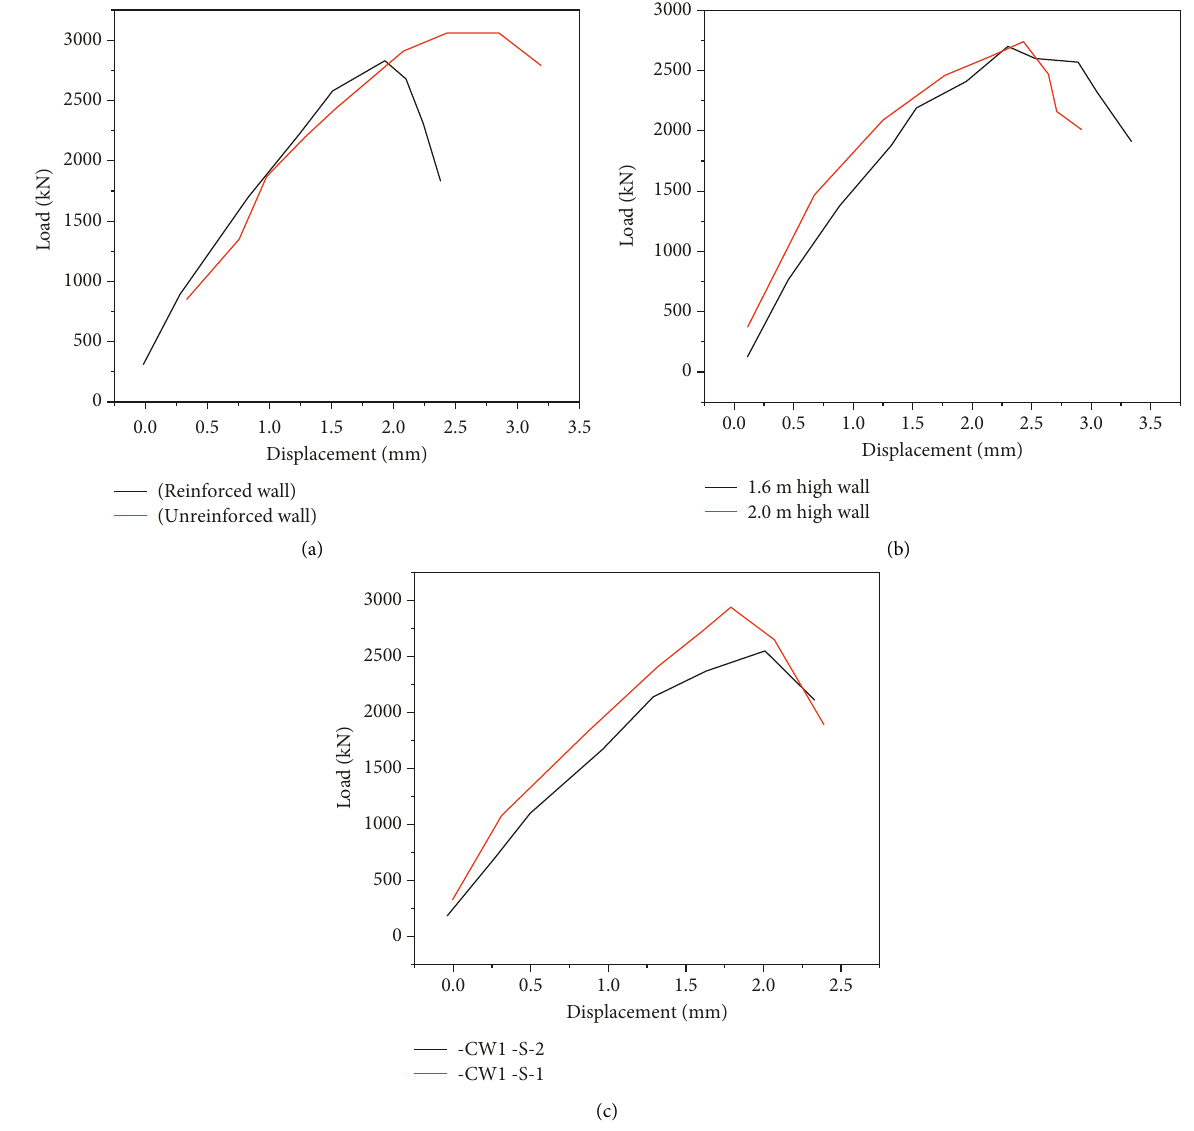
Figure 2: Wall load-displacement